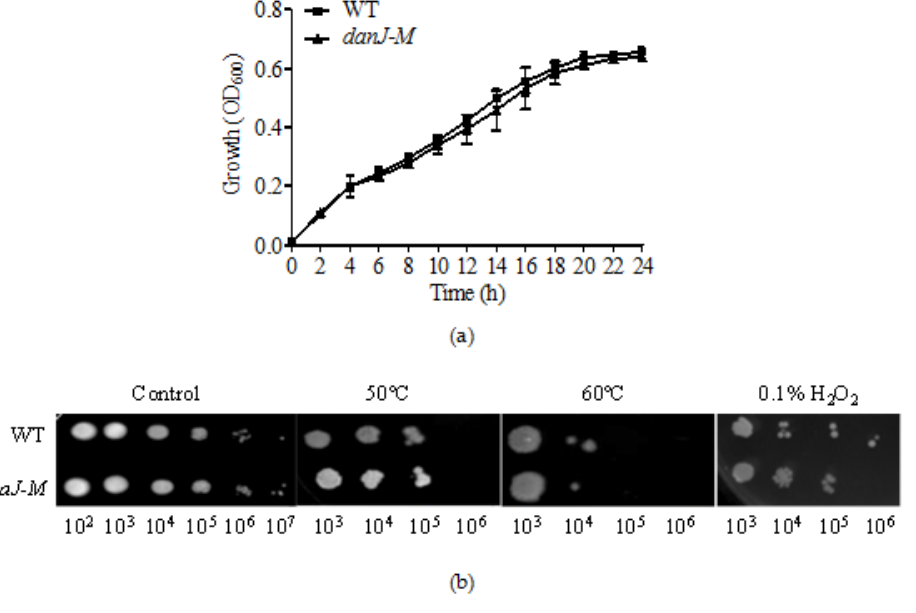
Figure 1. The growth profile of strains in Luria-Bertani (LB) broth and after different treatments. ( a ) Growth comparison in LB broth; ( b ) Survival after heat shock and H 2 O 2 treatment. Heat shock was carried out at 50 °C and 60 °C for 1 min, and H 2 O 2 treatment with the final concentration at 0.1% for 1 min. Serial dilutions are shown underneath the images. Untreated was used as a control. The results shown are representative of three independent experiments with similar results.